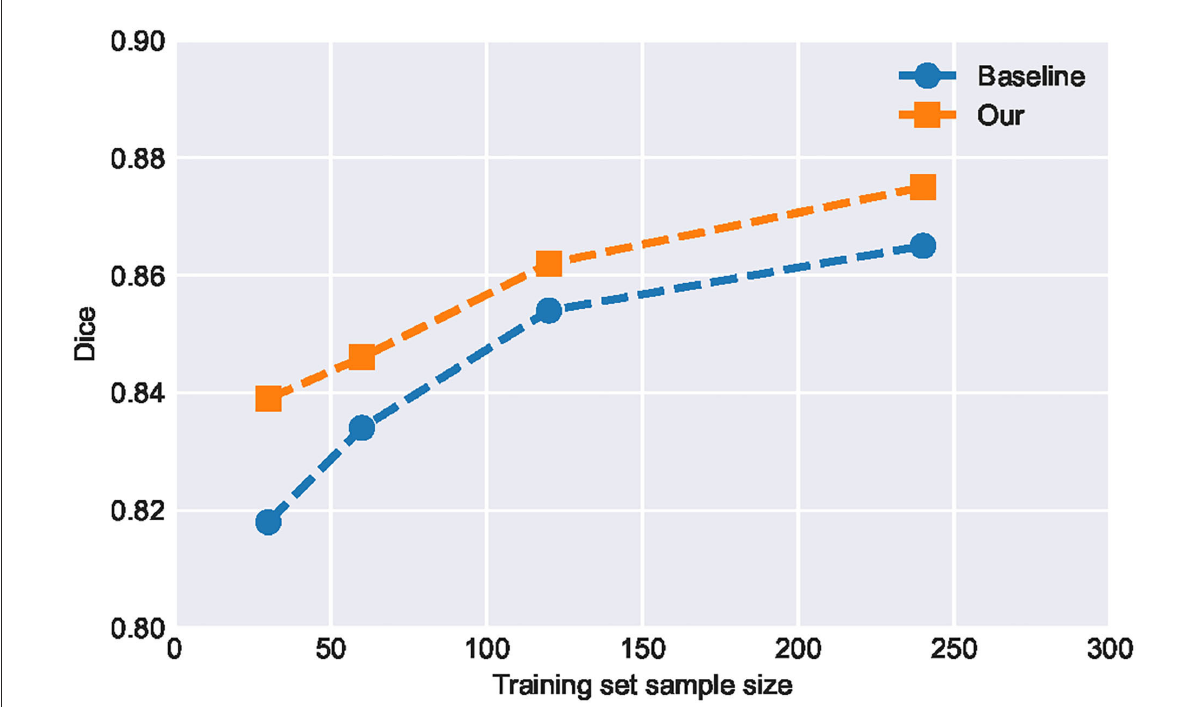
FIGURE7 Performance of SA-EN and baseline U-Net under different training set sample sizes. When the training set sample size is small, the effect of SA-EN is greater.